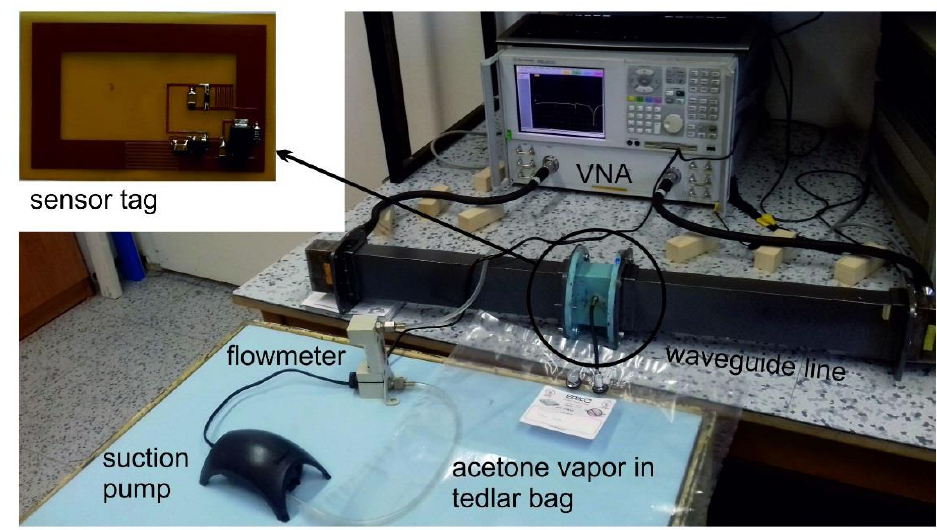
Figure 6. Photograph of the waveguide chamber measurement setup.